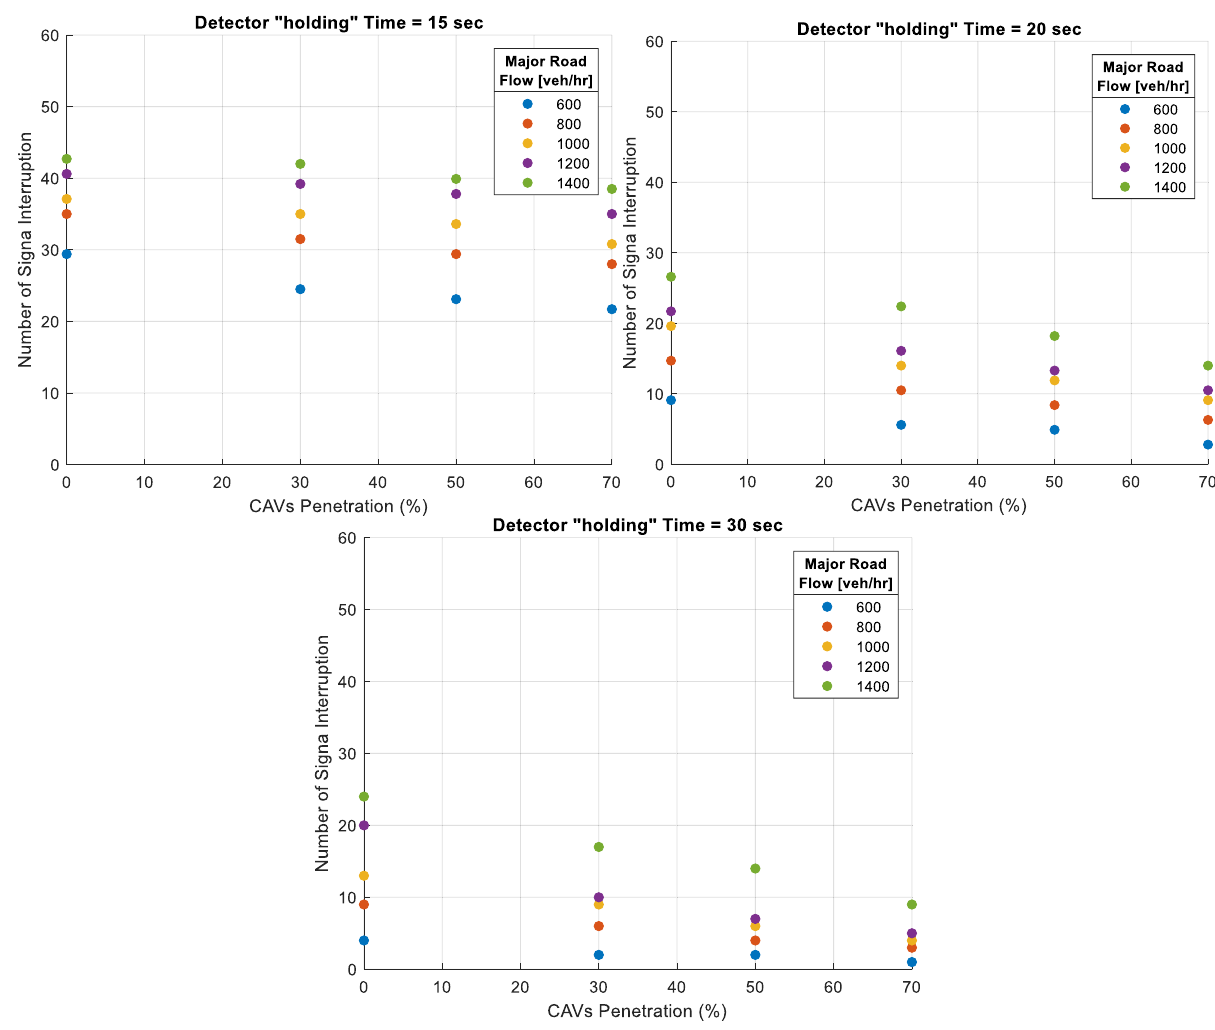
Figure 12: Signal interruptions on the mainline at 150 veh/h on the minor